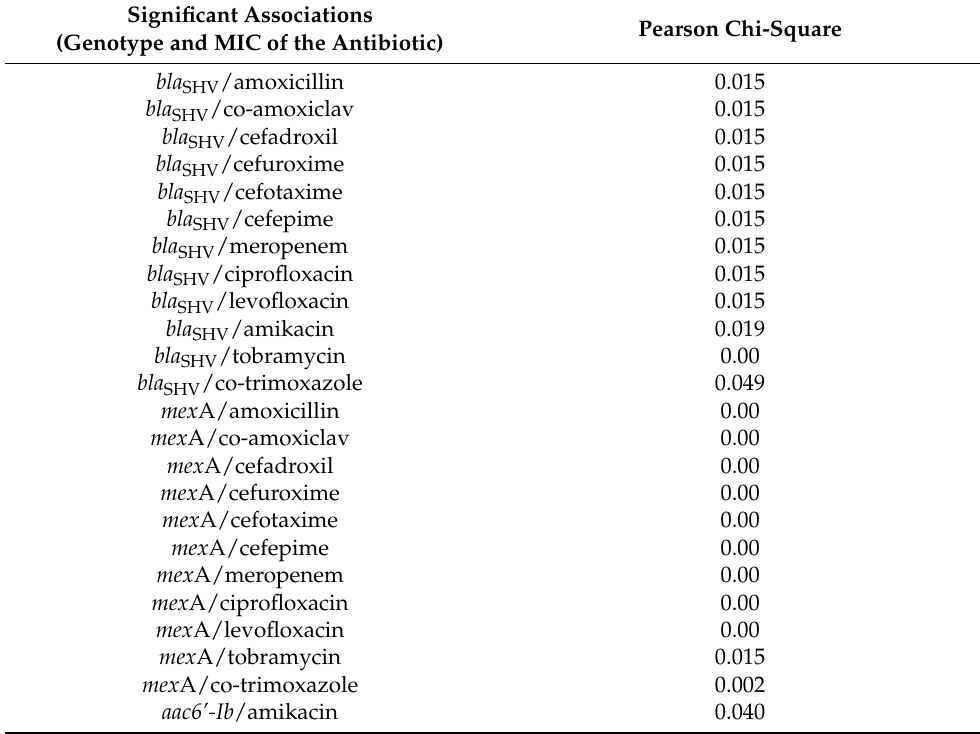
Table 4. Statistical association between genotype and minimum inhibitory concentration (MIC) of the antibiotics and their respective p